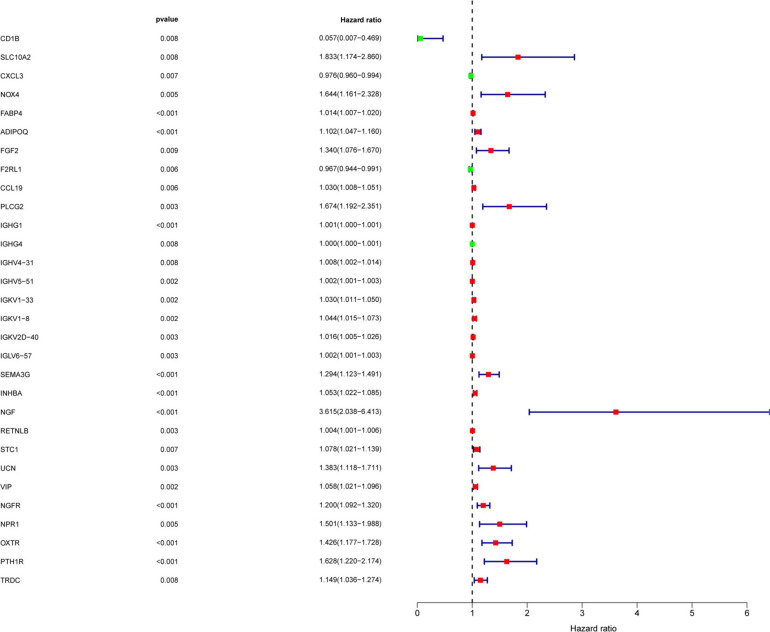
Screening of IRGs related to significant prognosis in CRC. Forest plot showing the prognostic immune-related genes, P values, and hazard ratios. Green dots represent low risk factors, and red dots represent high risk factors.